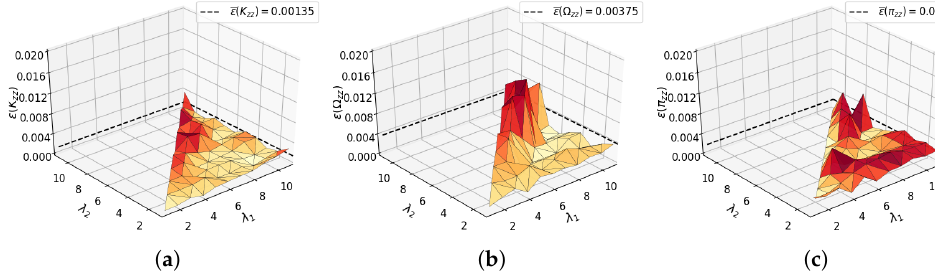
Figure 8. Modified relative errors ε are presented, with respect to λ 1 and λ 2 , for the examples of tensor components K zz , Ω zz and Π zz , shown at ( a – c ) sections respectively. Parameters e 1 and e 2 are fixed to unity. The average error for the plot is displayed in the top right